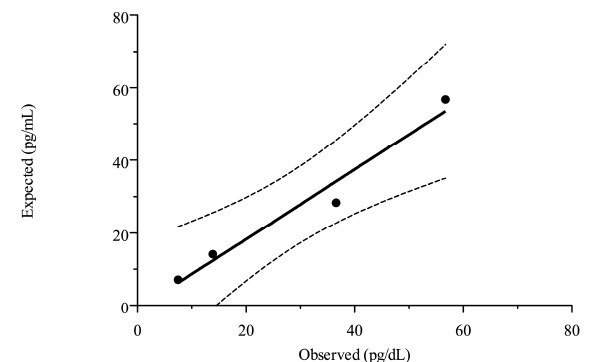
Figure 1. Linearity under dilution of the “high pool” obtained by mixing 6 samples with high big endothelin-1 concentration. The black solid line represents the linear fit between expected and observed data and the black dashed line represents the 95% confidence interval.